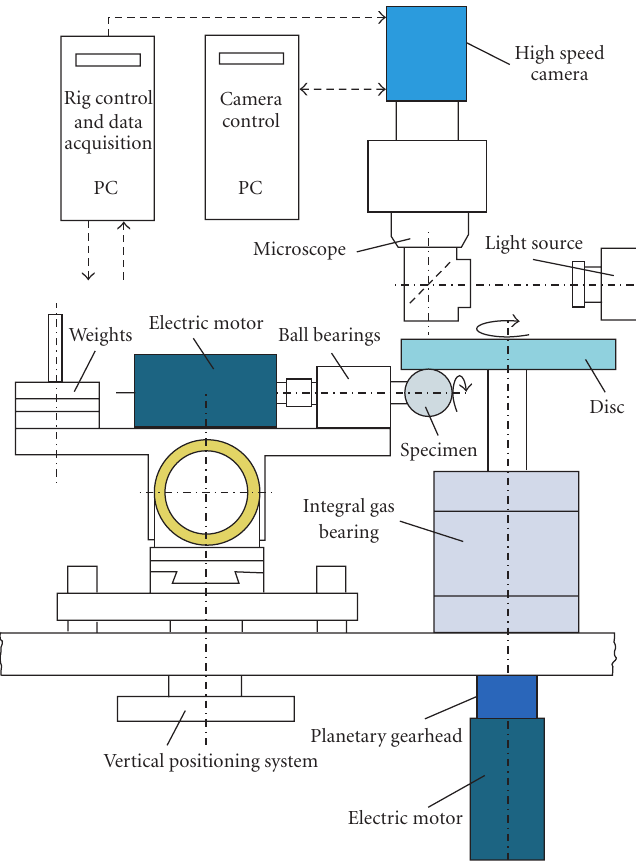
Figure 11: Schematic drawing of the test